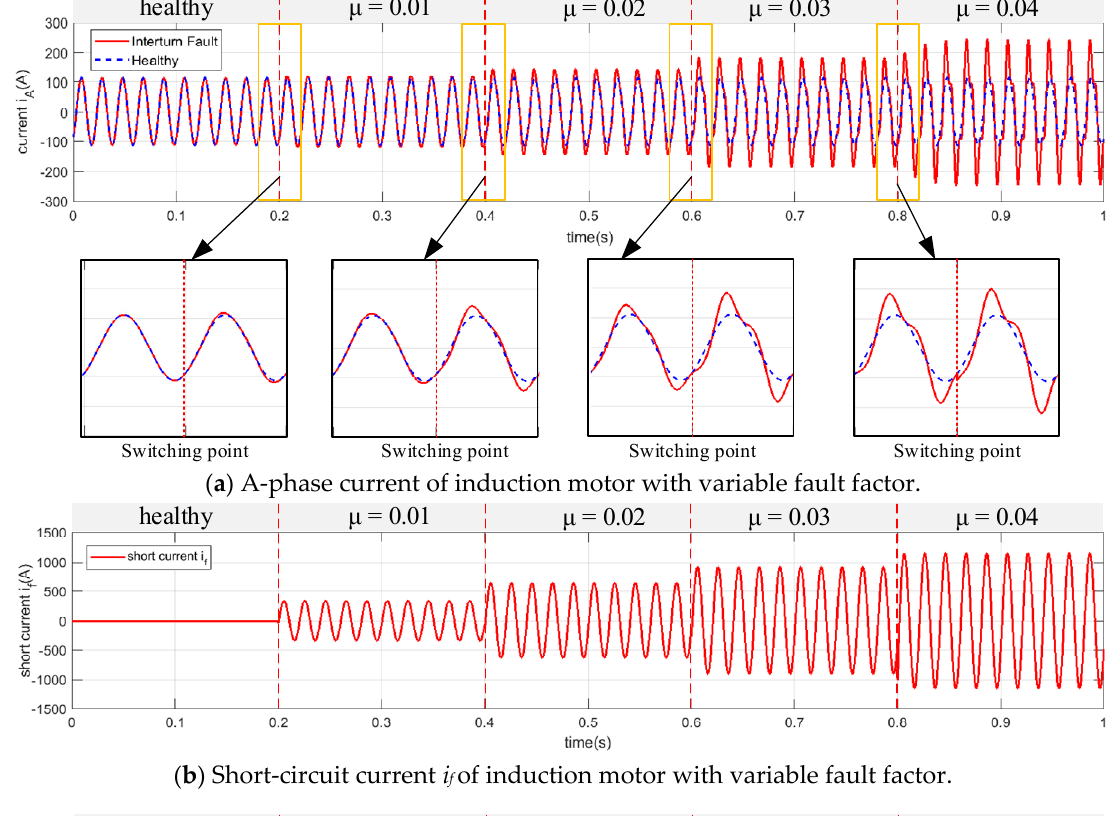
8 of 11 Table 1. Motor parameters. Parameter